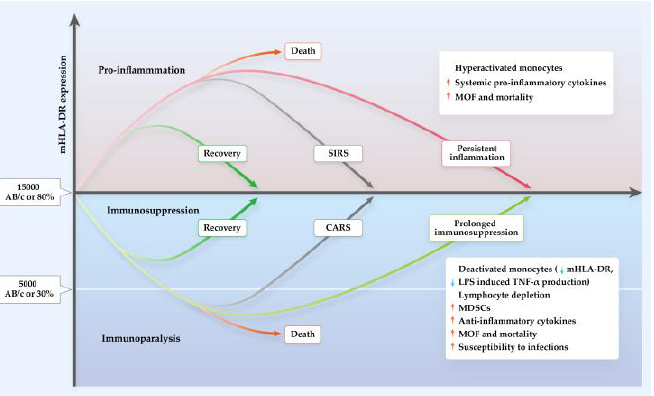
Figure 4. Immune response in AP and COVID-19. Figure adapted from [121,122]. Pro- and anti-inflammatory response are both activated after acute insults of either AP or COVID-19. The initial generalized inflammation is individually heterogeneous. Patients with less intense generalized inflammatory response may survive and restore the immune balance. When inflammation markedly outpaces anti-inflammation, monocytes are hyperactivated, leading to increased systemic release of pro-inflammatory cytokines and resulting in systemic inflammatory response syndrome (SIRS). This cytokine storm and hyperinflammation is associated with multiple organ failure (MOF) and mortality in AP and COVID-19. Conversely, compensatory anti-inflammatory response syndrome (CARS) happens when the anti-inflammatory response is overwhelming. mHLA-DR is an indicator of this, and expression below 15,000 AB/c or 80% characterizes immunosuppression and below 5000 AB/c or 30% characterizes immunoparalysis. In addition to pronouncedly reduced mHLA-DR expression, monocytes are deactivated with TNF- α production upon lipopolysaccharide (LPS) stimulation in CARS. Lymphocytes are depleted, accompanied by a massive release of anti-inflammatory cytokine. This dysregulated and persistent immunosuppression contributes to MOF, death, and